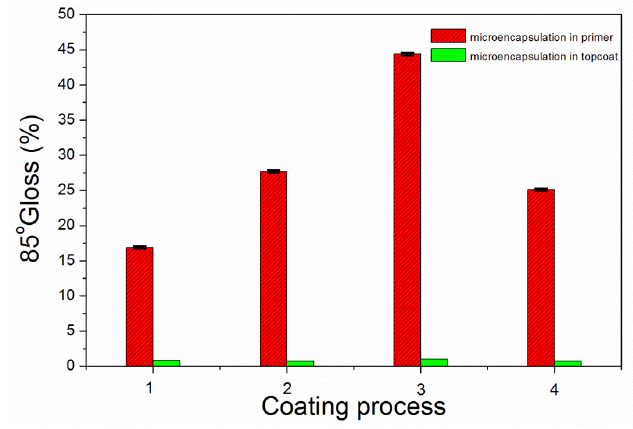
Figure 10. Gloss variation of coating at 60 ◦ incident angle (samples 1–4 from Table 1).